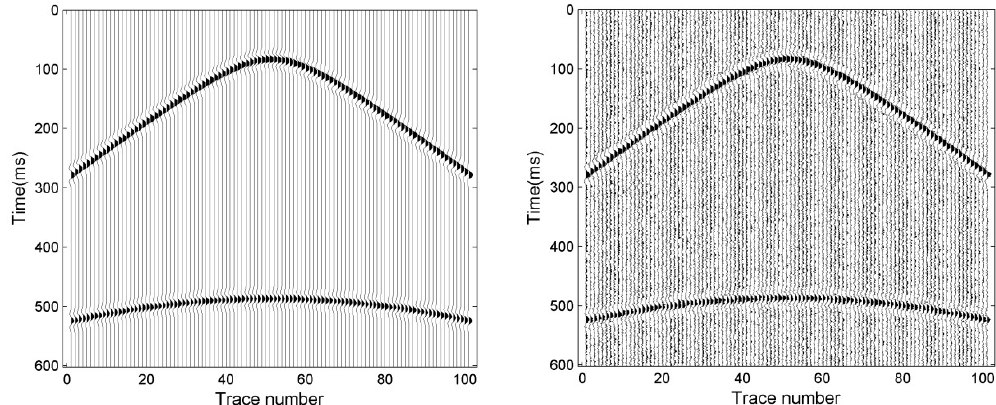
Figure 7. Synthetic seismic records without noise ( left ) and with 20% noise ( right ).